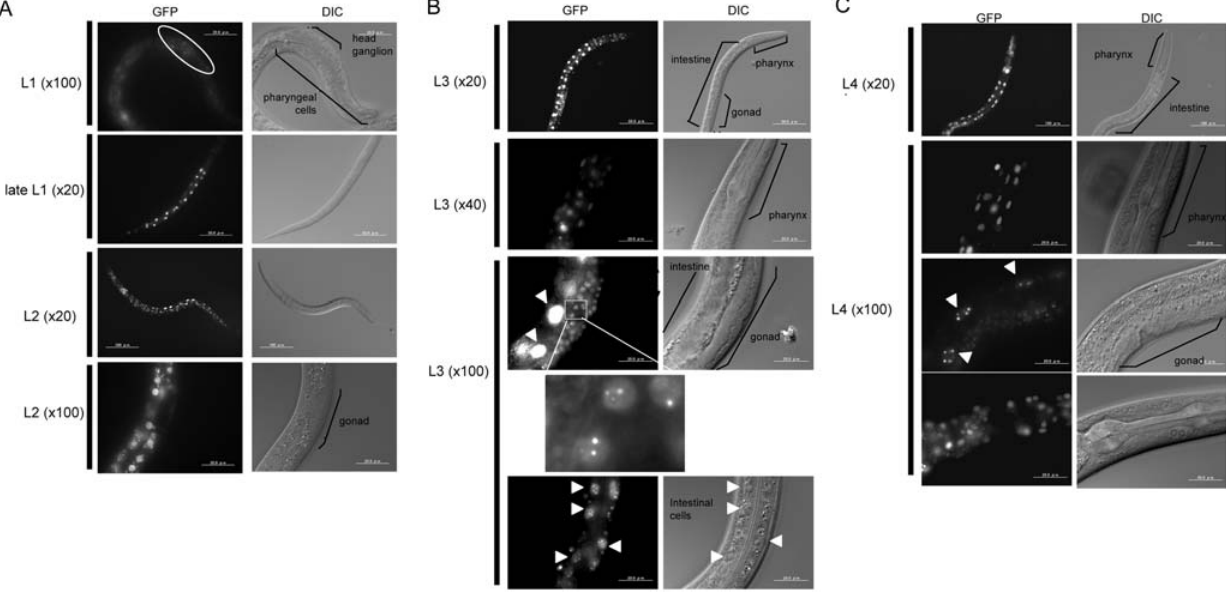
Figure 3. Pqbp-1.1-Venus fusion protein expression during larva stages. A) At L1 stage, pqbp-1.1-Venus fusion protein is expressed in progenitor neurons in head ganglion. Expression in intestinal cells increases from L1 to late L1 stgae. At L2 stage, pharyngeal and intestinal cells show strong signals. Gonad does not express the fusion protein. B) At L3 stage, pharyngeal and intestinal cells keep a high expression level of pqbp-1.1. Especially, intestinal cells the highest expression level during the development. Somatic gonads also show high signals, and a higher magnification reveals nuclear dots of fusion protein, which is similar to the intranuclear localization of mammalian PQBP1 [11]. Arrowheads indicate intestinal cells. C) At L4 stage, a small number of pharyngeal and intestinal cells show strong signals of pqbp-1.1-Venus. The nuclear dots of the fusion protein are observed in intestinal cells (arrowheads) similarly to L3 stage. Somatic gonads also show weak signals.